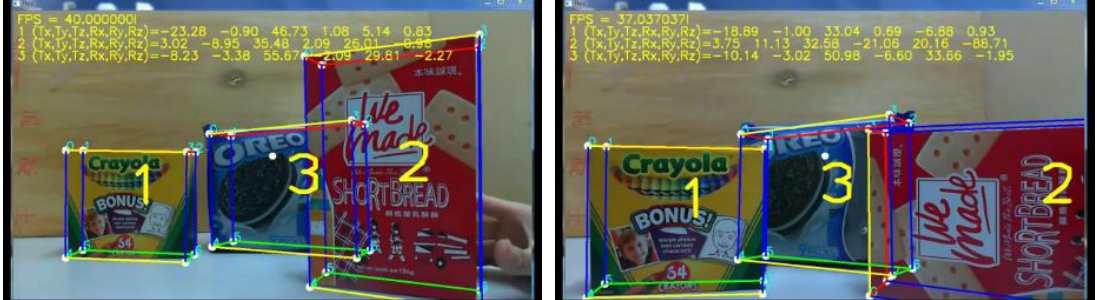
Figure 6. Experimental results of multi-object pose tracking of the proposed algorithm [32].